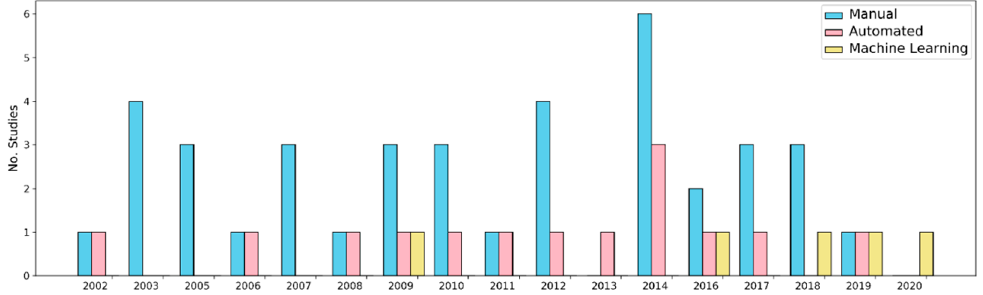
Figure 4. Bar plot showing number of processing methods applied to multibeam echosounder, side scan sonar, photogrammetry, and repeat mapping in CWC habitats.